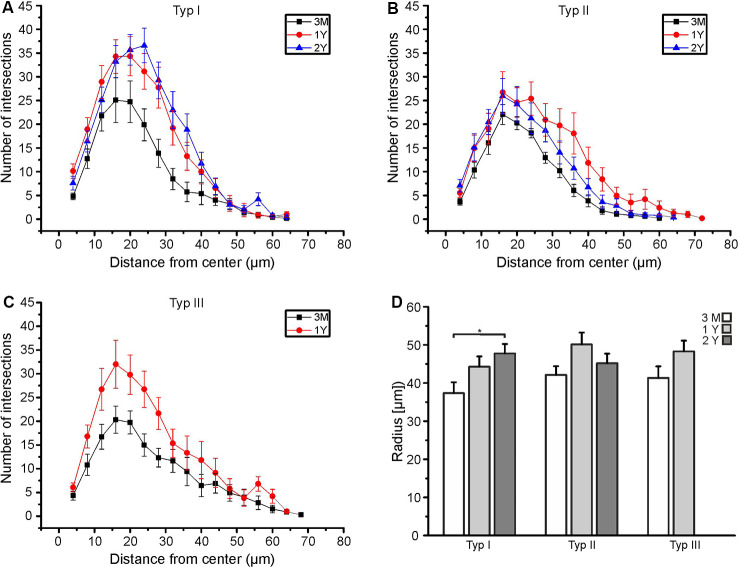
Age-dependent Sholl analysis of astrocytes. (A) Sholl plot of type I astrocytes, (B) type II astrocytes and (C) type III astrocytes at an age of 3 months (black), 1 year (red), and 2 years (blue). (D) Averaged maximum radii of all astrocytes analyzed. Type I astrocytes significantly increased in the maximum radius between 3 months and 2 years (*p < 0.05).